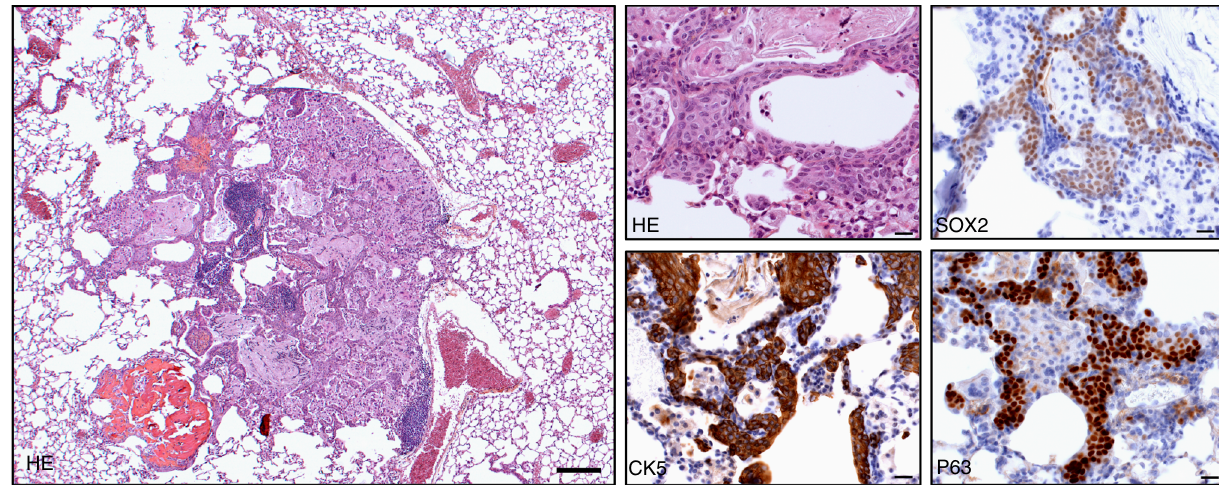
Fig. 2 Cdkn2ab − / − mice show squamous lung metaplasia. H&E (scale bars 200 μ m and 20 μ m) and CK5, SOX2 and P63 IHC (scale bar: 20